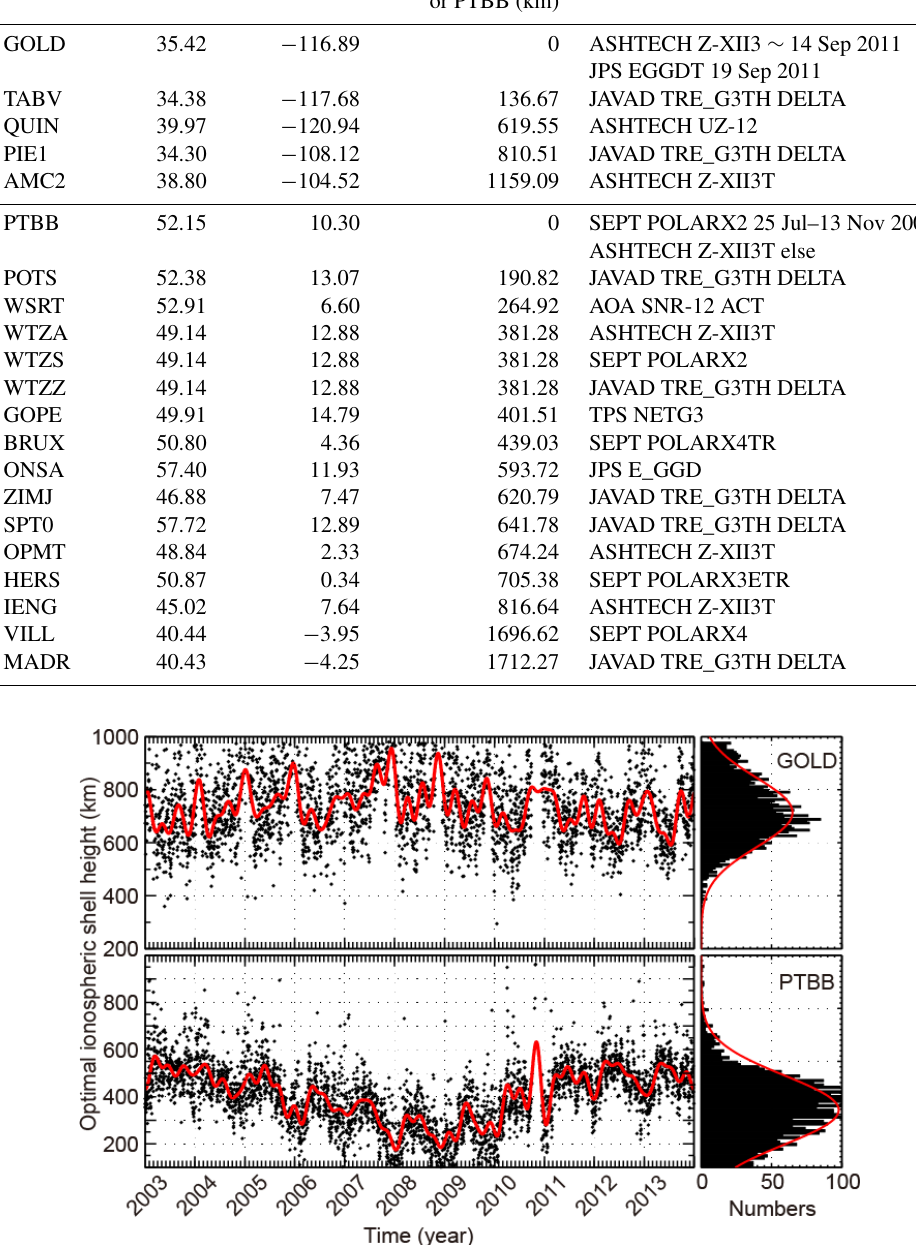
values are reduced to 0.12 and 0.08 TECu, respectively; the root mean squares are reduced by 4.43 and 4.33 TECu,